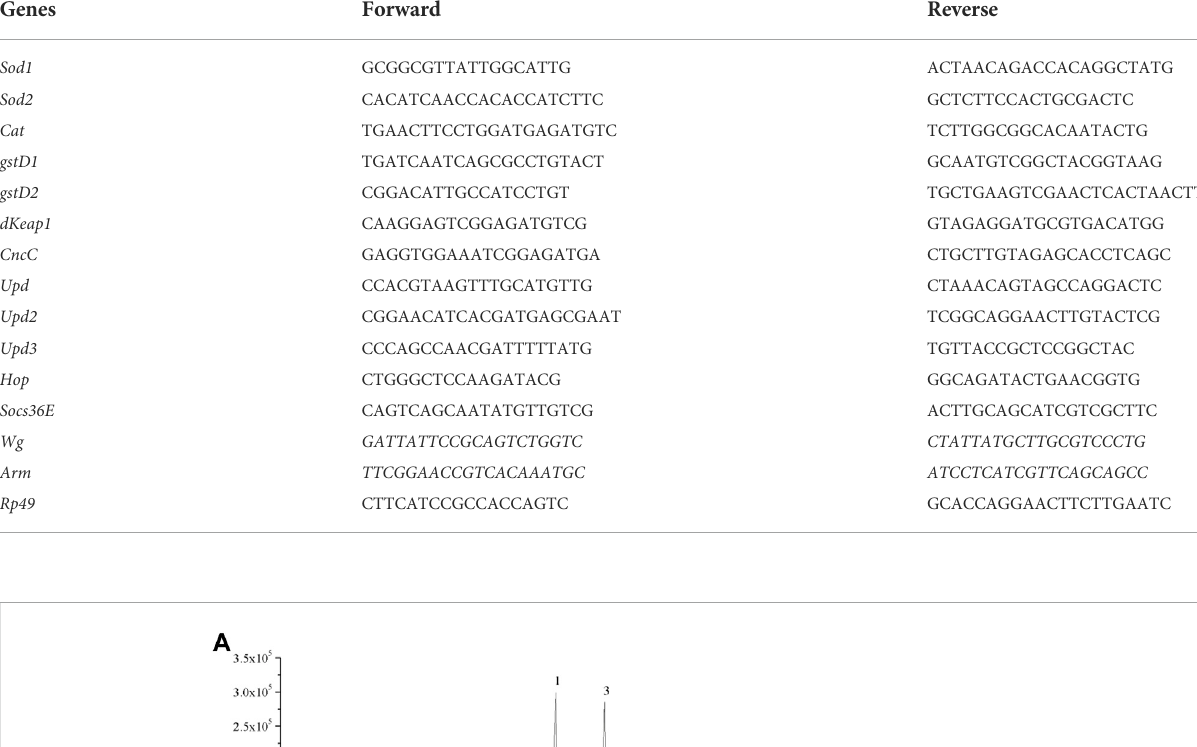
TABLE 1 List of forward and reverse primers used in gene expression studies.